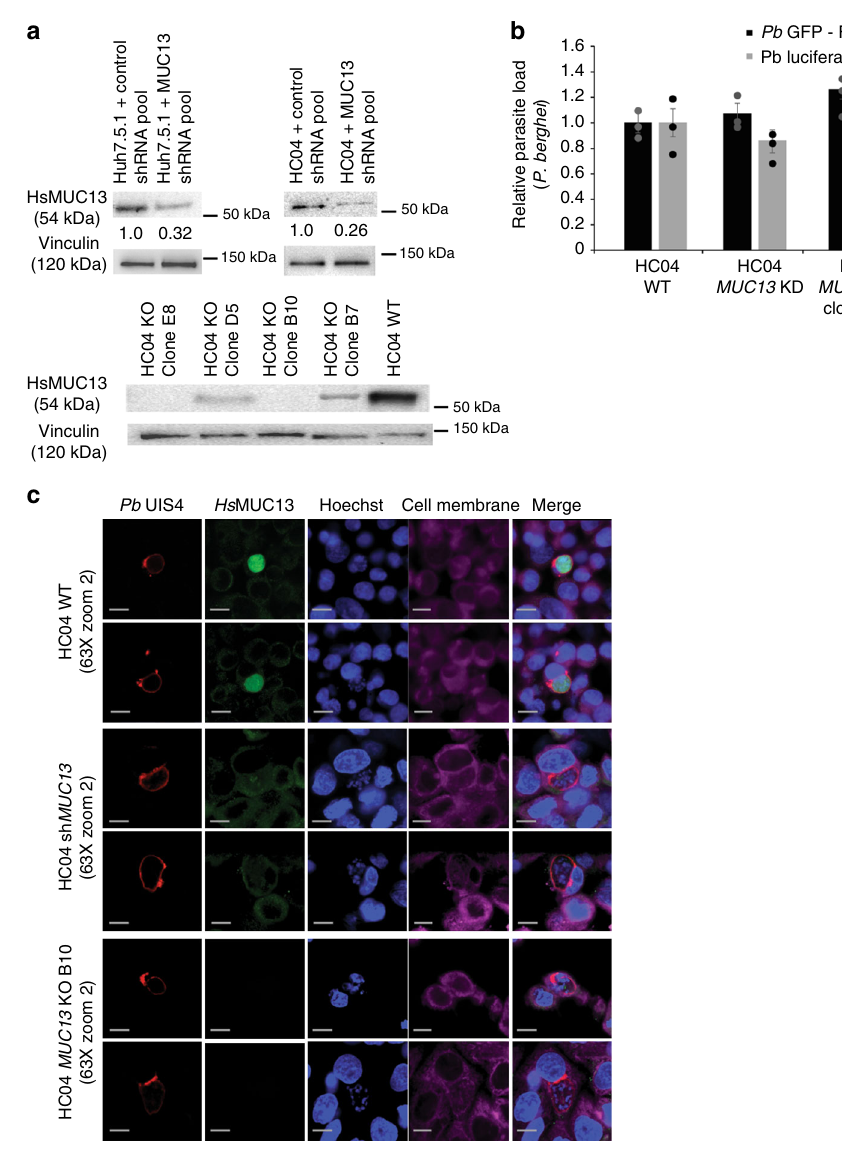
Fig. 5 Con fi rmation of antibody speci fi city in regards to Hs MUC13 ’ s localization within P. berghei during liver-stage infection. a Con fi rmation of both MUC13 knockdown, in cells expressing a pool of four anti-mucin13 shRNAs which have been integrated into the hepatocyte genome, and MUC13 knockout, via CRISPR/ Cas9 , during infection via western blot. Values indicated are relative protein expression as determined by densitometry. b Effect of MUC13 knockdown and knockout in the indicated cells infected with P. berghei expressing either luciferase (measured via total luminescence) or GFP (measured by FACS). Data is presented as mean ± s.e.m with n = 3 with individual biological replicates overlaid. c Confocal microscopy images of HC04 liver cells, either unmodi fi ed (WT), expressing an shRNA pool for MUC13 (KD) or with MUC13 knocked out (KO clone B10), infected with P. berghei 48 hpi. Cells were labeled with a rabbit polyclonal antibody (dilution 1:500, 1 mg/ml stock) against the intracellular domain of Hs MUC13 (MUC13 antibody #1 AbCam #Ab65109). P. berghei was detected using a UIS4 antibody (1:500 dilution, 1 mg/ml stock LS-204260, LifeSpan Biosciences). Primary antibodies were detected with a goat anti-rabbit (Alexa Fluor 488, green) and a goat anti-mouse (Alexa Fluor 647, red). Cell membranes and nuclei were stained with Hoechst 33342 (blue) and CellMask deep red (magenta), respectively. Merged images between Hs MUC13, P. spp HSP70, and Hoechst shown. Scale bars 10 μ m; 63× oil